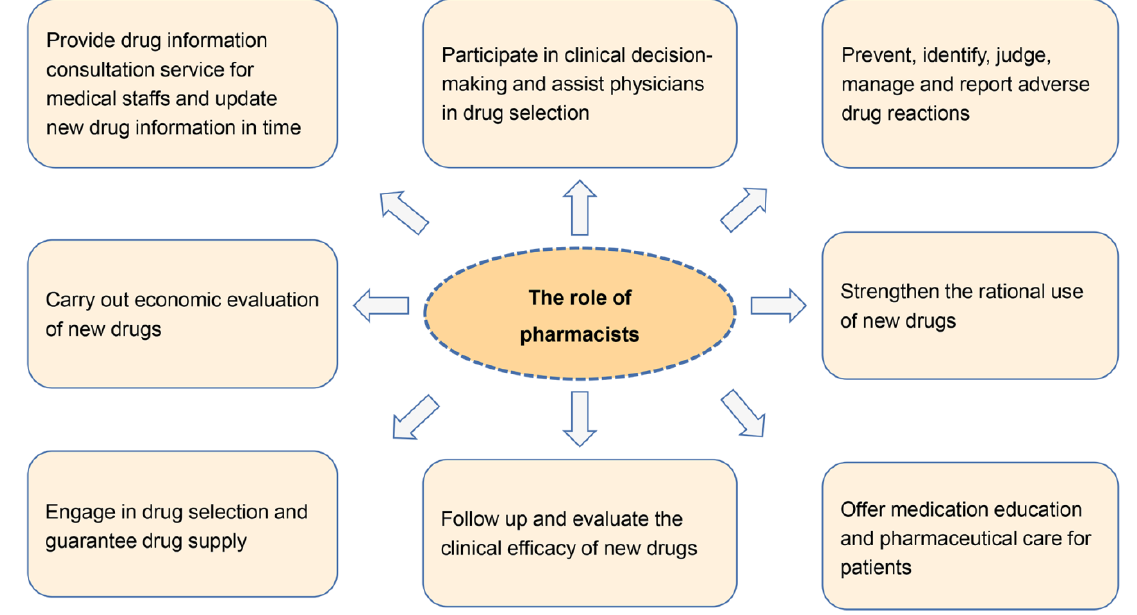
Figure 3. The role of pharmacists in the clinical application of novel antitumor drugs.